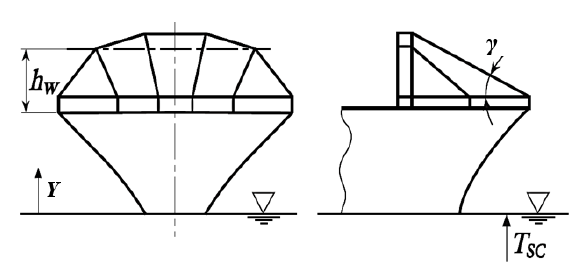
Figure 4. Breakwater height illustration for turtle decks (DNV-GL 2015).